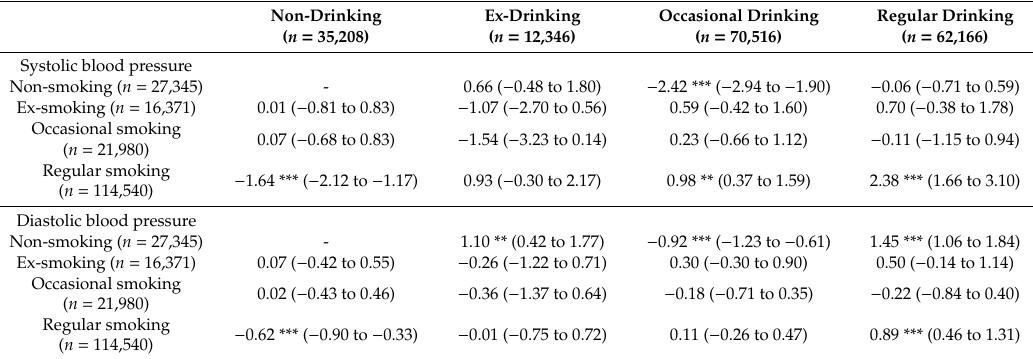
Table 4. Multivariable a linear regression coe ffi cients (95% confidence interval) for systolic and diastolic blood pressure levels according to smoking and alcohol consumption status in men.